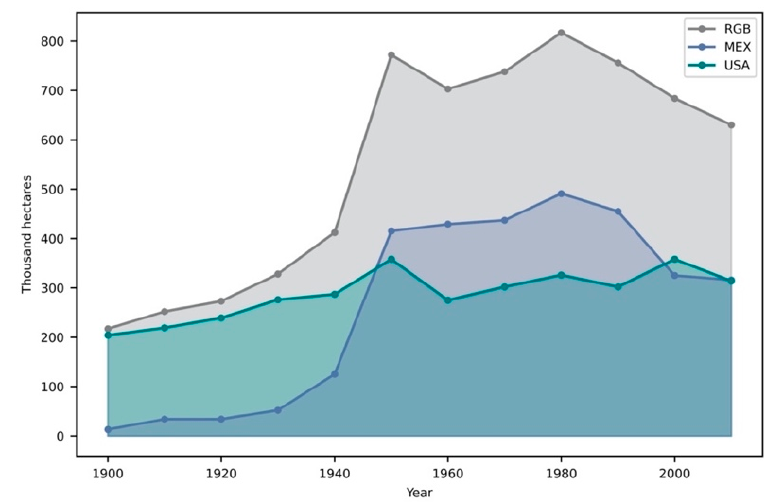
Figure 3. Accumulated agriculture hectares (thousand hectares) in the Rio Grande–Bravo Basin (grey) and the portions of the United States (green) and Mexico (blue).